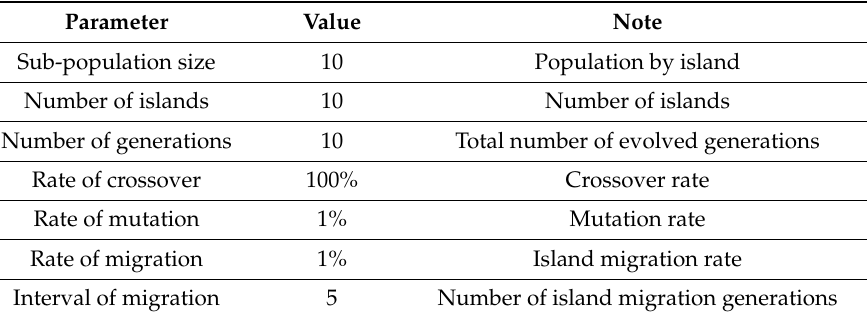
Table 6. Parameters of multi-island genetic algorithm.